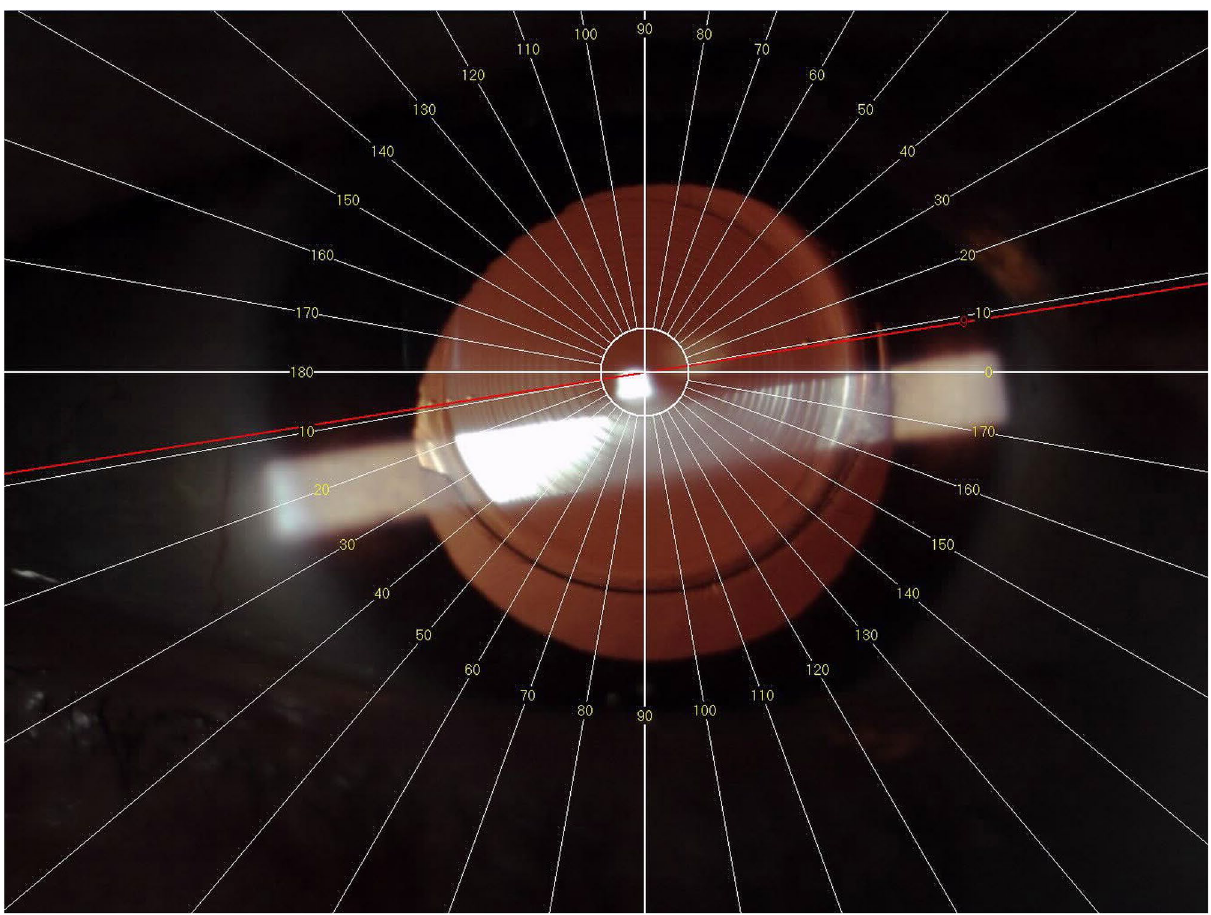
Figure 1. Example of a Retroillumination photo documentation of a TIOL position, using the Goniotrans software (Eventos Médicos y Sociales, SL). By dragging the radial line to the position of the TIOL axis mark on the angles pattern the position of the TIOL is determined.